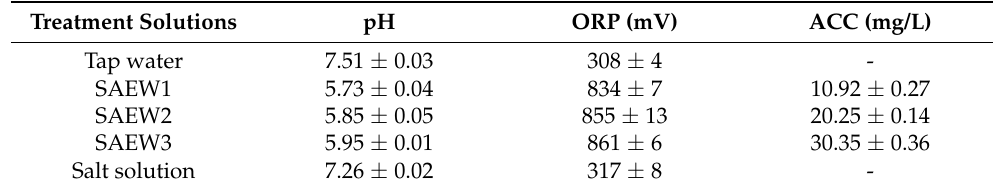
Table 1. The physicochemical parameters of the treatment solutions 1